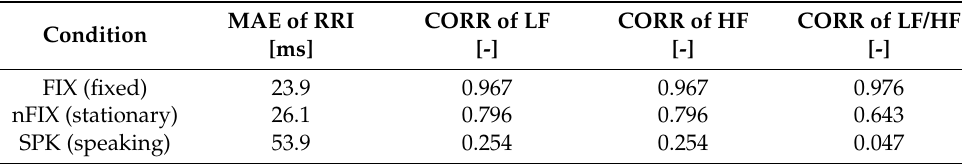
Table 1. Mean absolute error (MAE) of RRI and correlation coefficient of